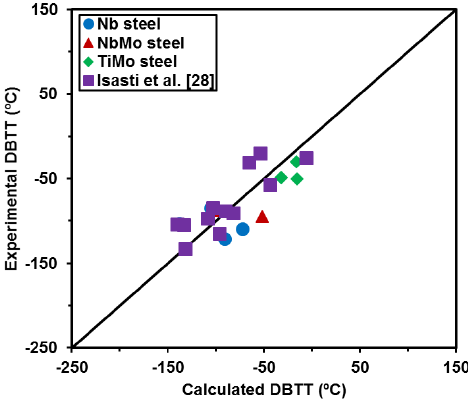
Figure 11. Comparison between experimental and calculated DBTT values predicted by Equation (9). The results obtained by Isasti et al. [28] have been included.